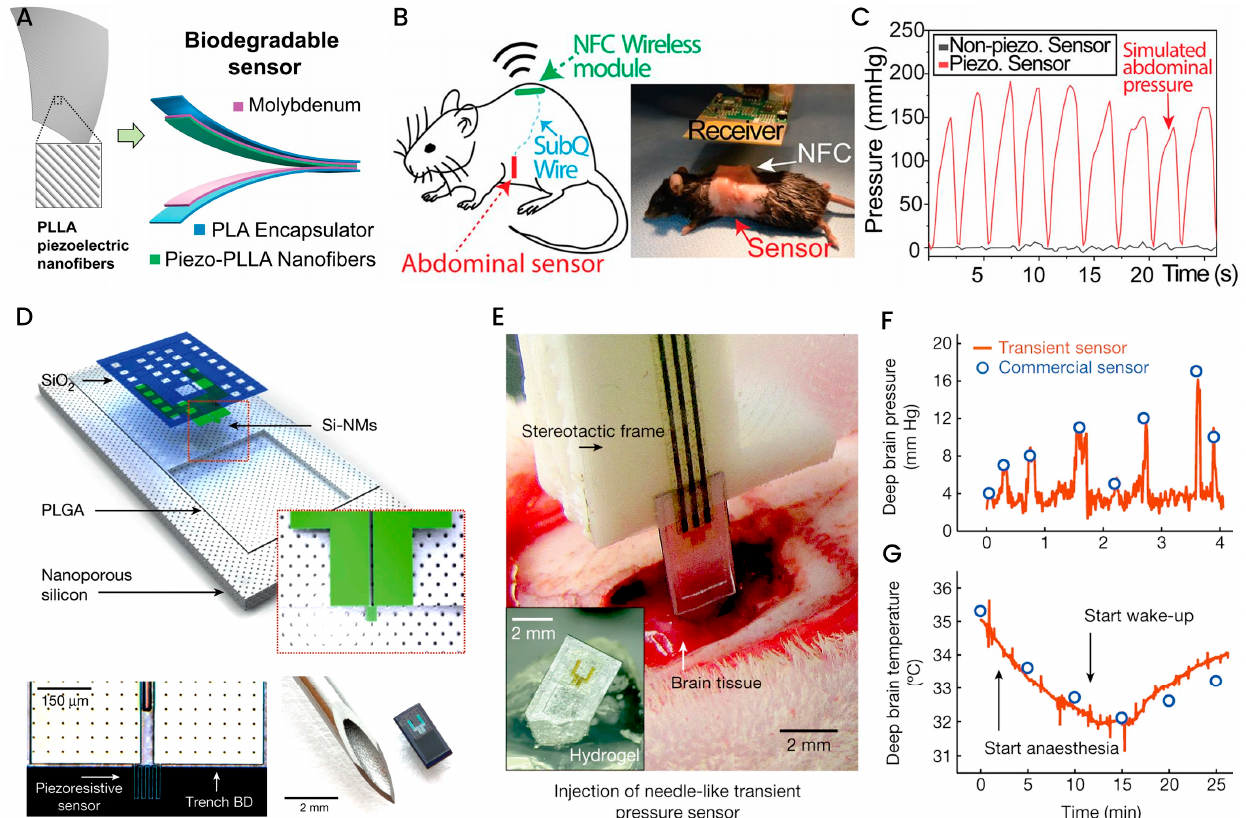
Figure 8. Demonstration of biophysical sensing using implantable biosensors. ( A , B ) Implantable piezoelectric device’s structure and implantation in mouse abdomen. ( C ) Depressed and relaxed progression measurement of the pressure signal response [69]. ( D , E ) Structure of a piezoresistic device for the measurement of temperature and pressure and its implantation in the brain. ( F , G ) Data of the temperature and pressure collected by the device in comparison with a commercial sensor. Reproduced with permission from ref. [22] ©2016 Springer-nature Ltd.